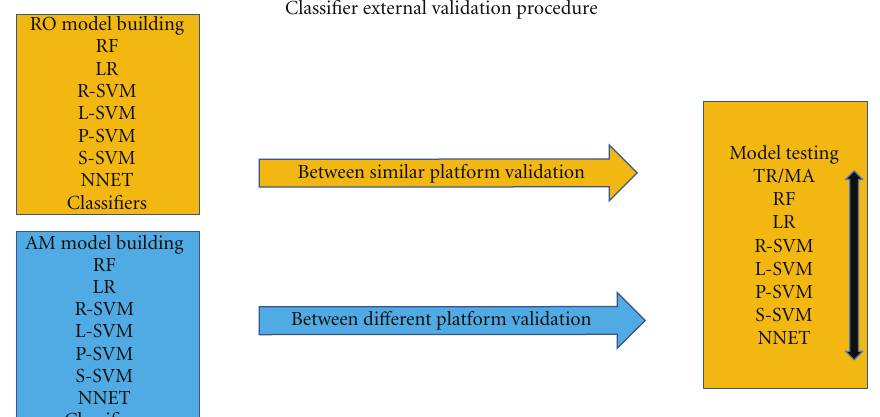
Figure 4: The procedure for external validation of classifiers. External classifier validation. Two datasets were used for training (AM and RO), and two others for testing (TR and MA). Datasets based on the A ff ymetrix and Agilent platforms are shown in orange and blue, respectively. RO and AM classifiers were used for evaluating external validation of classifiers developed from datasets using similar platform and using di ff erent microarray platforms, respectively. The models built in RO were tested in TR and MA and their mean performance calculated. This was done for all classification methods and compared. The same was done for testing AM models.